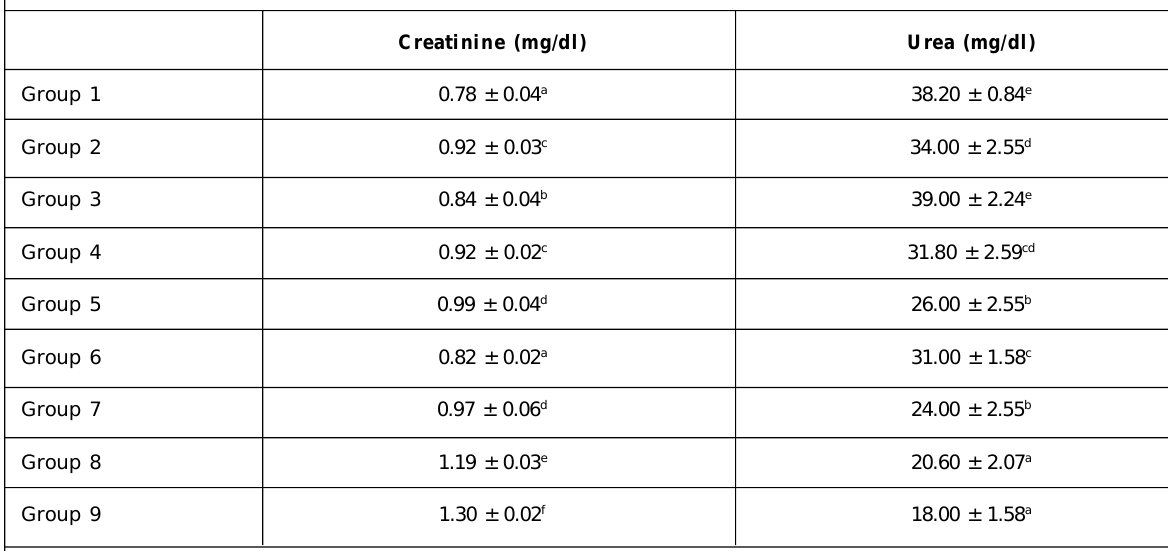
Table 4: Renal function assessment of female albino